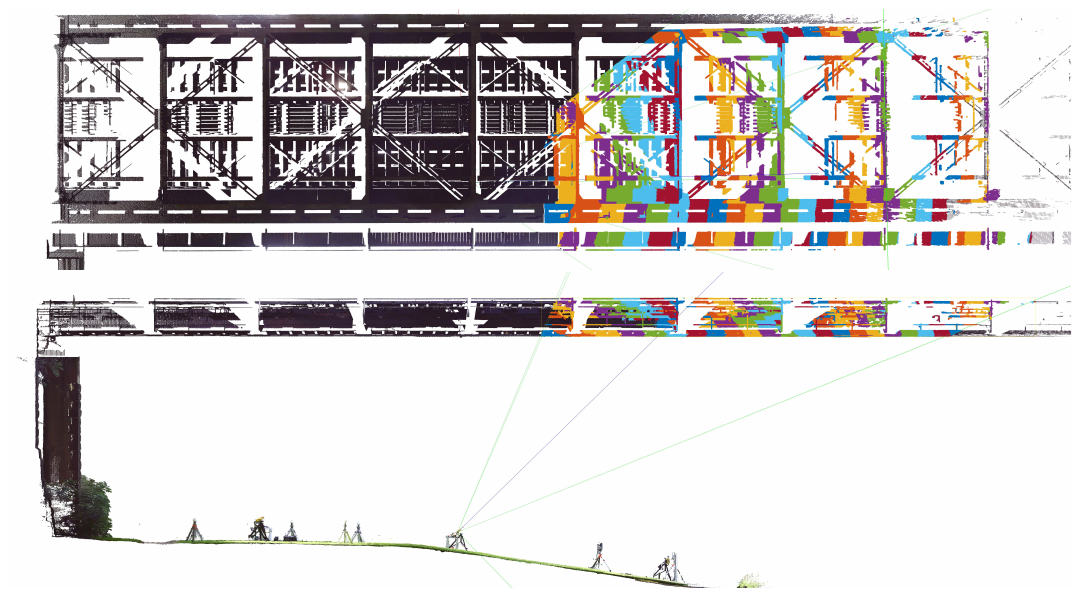
Figure 8. Top and side view of the bridge with the projected resolution cells (color-coded) of the IBIS-S for Setup